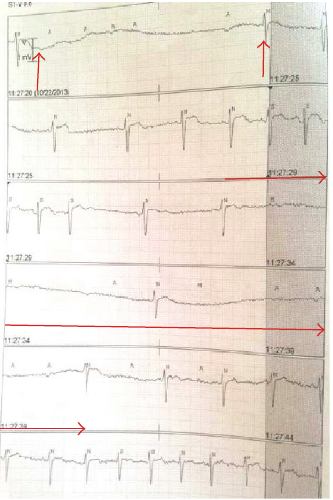
Figure 1: EKG strips with arrows outlining sudden progression of sinus tachycardia to asystole for more than 15 seconds before an escape beat and return of sinus rhythm (spontaneously).